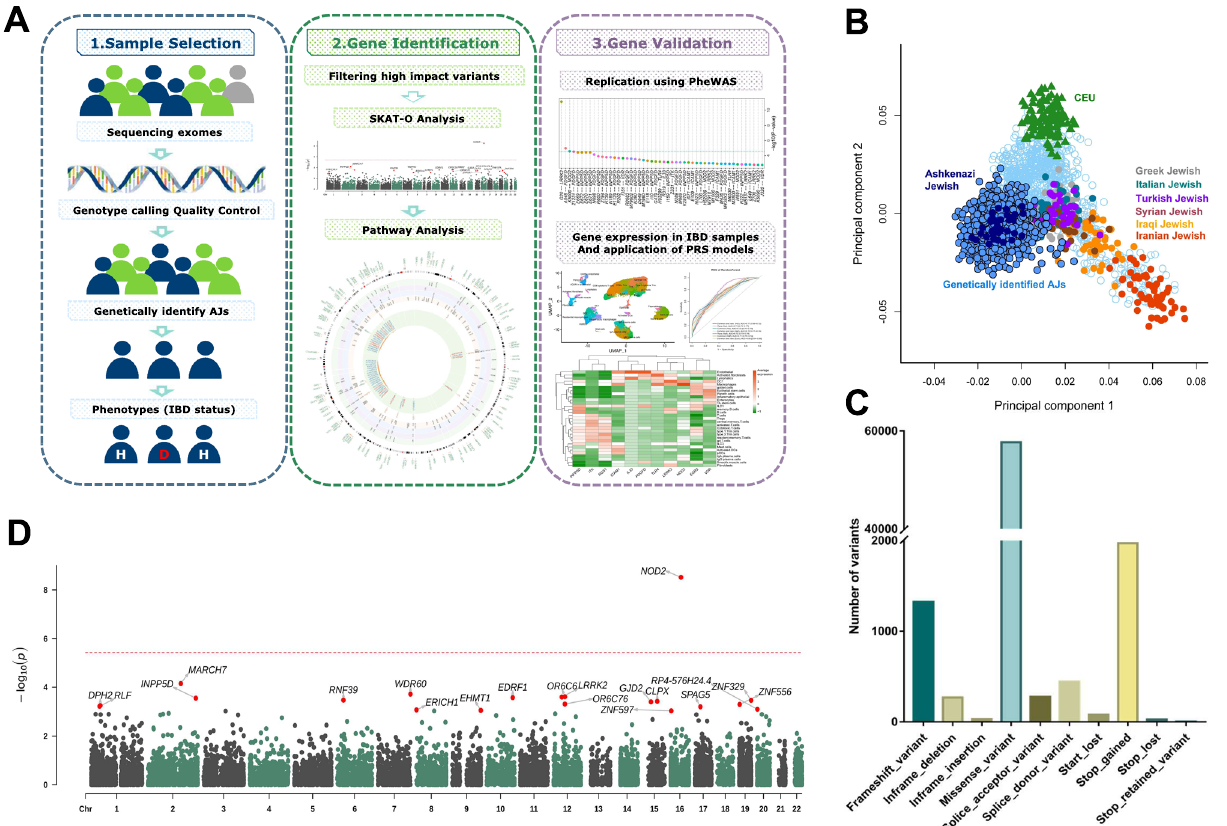
Fig. 1 | Ashkenazi Jewish population-speci fi c case-control study using high- impact variants revealed IBD-associated genes. A Flowchart of present work. Firstly, AJ samples from all WES participants that passed quality control